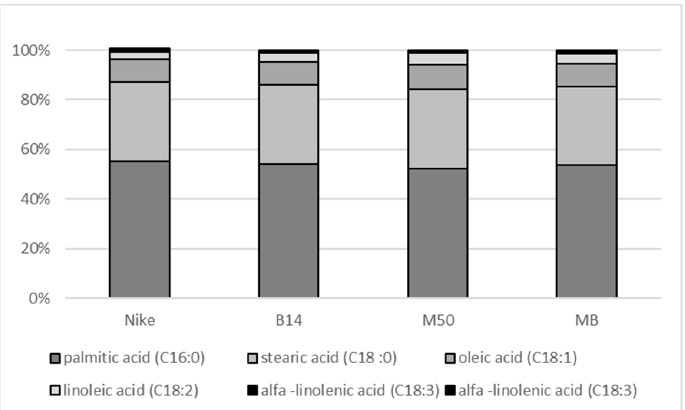
Figure 2. The percentage of fatty acid in the fabric. Table 2. Content of other bioactive compounds per cm 2 of fabric—the measurement was made after the sterilization (average of 5–6 independent samples obtained from different parts of the fabric). The statistical significance of the differences between the results for the tested linen fabrics com- pared to the control was calculated using the Tukey post hoc test ( * p < 0.05). µg/cm 2